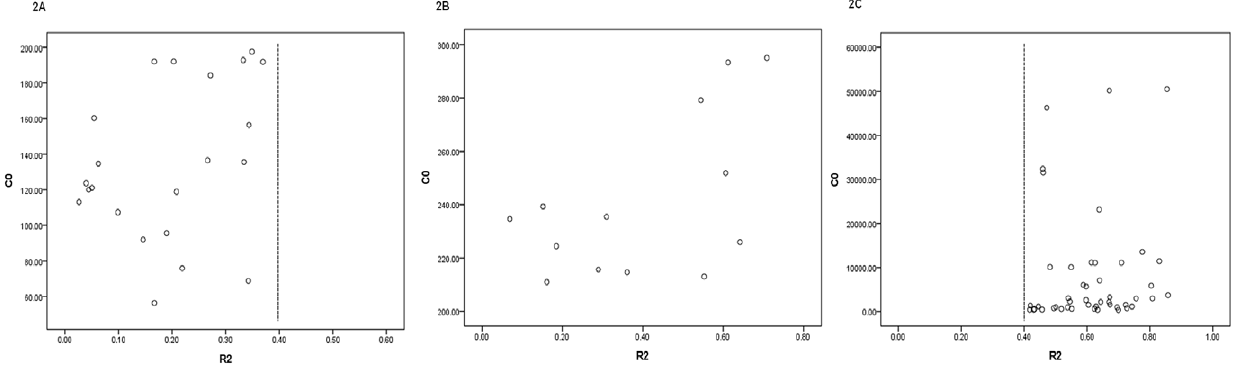
PLoS ONE | www.plosone.org